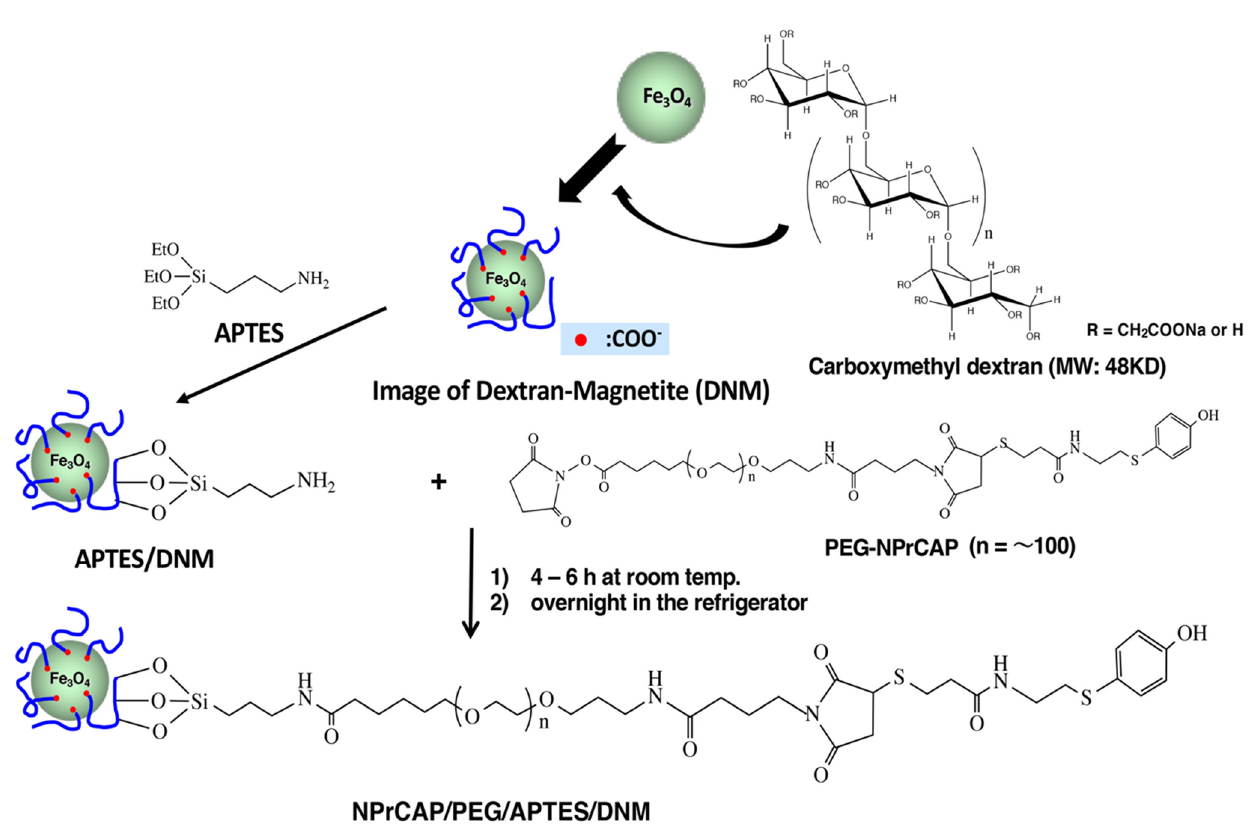
Figure 6. Image of DNM and synthesis of NPrCAP/PEG/APTES/DNM.